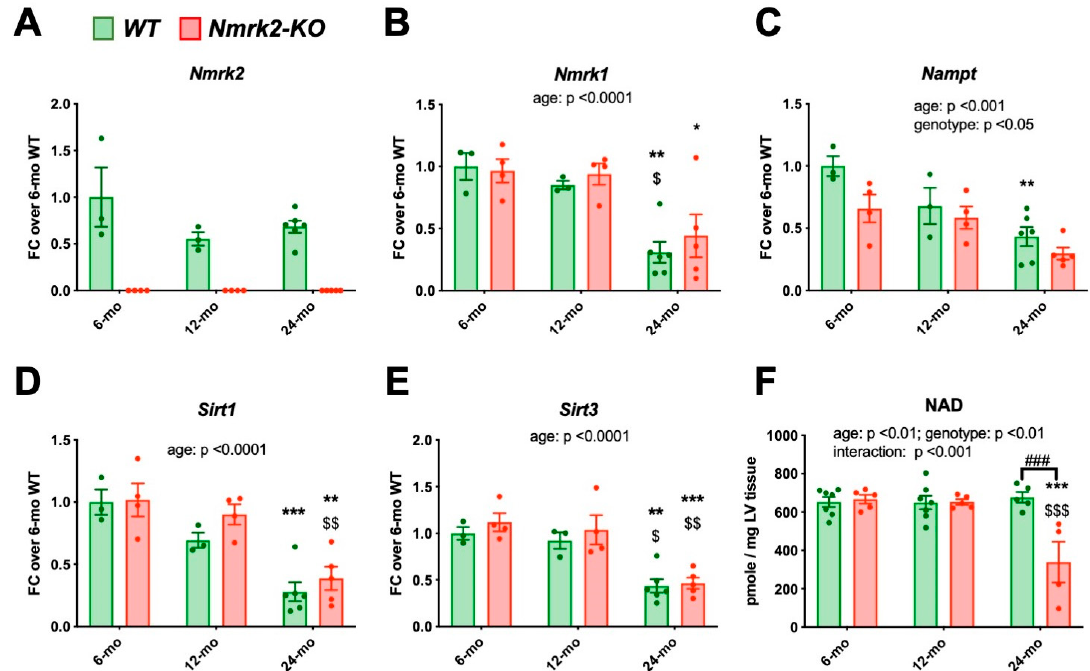
Figure 5. Expression level of genes involved in NAD salvage pathway and quantification of NAD contents in the heart of control and Nmrk2 KO mice. ( A–E ) RT-qPCR analysis of cardiac mRNA from control ( n = 3–6) and Nmrk2-KO mice ( n = 4–5) at the age of 6, 12 and 24 months. Data are normalized on Gapdh reference mRNA level and expressed as fold change over the mean value of controls at 6 months. ( F ) Myocardial NAD levels. Individual data are shown by dots. Bars and error bars represent the mean value ± SEM. Statistics: Two-way ANOVA for independent samples: Factors p values are indicated are indicated next to the graph title. On bars, Post-hoc Tukey’s multiple comparison test: *, p ≤ 0.05; **, p ≤ 0.01; ***, p ≤ 0.001 24 months vs 6 months within the same genotype; $, p ≤ 0.05, $$; p ≤ 0.01; $$$; p ≤ 0.001, 24 months vs 12 months within the same genotype. ###, p ≤ 0.001, Nmrk2-KO mice vs wild type within the same age